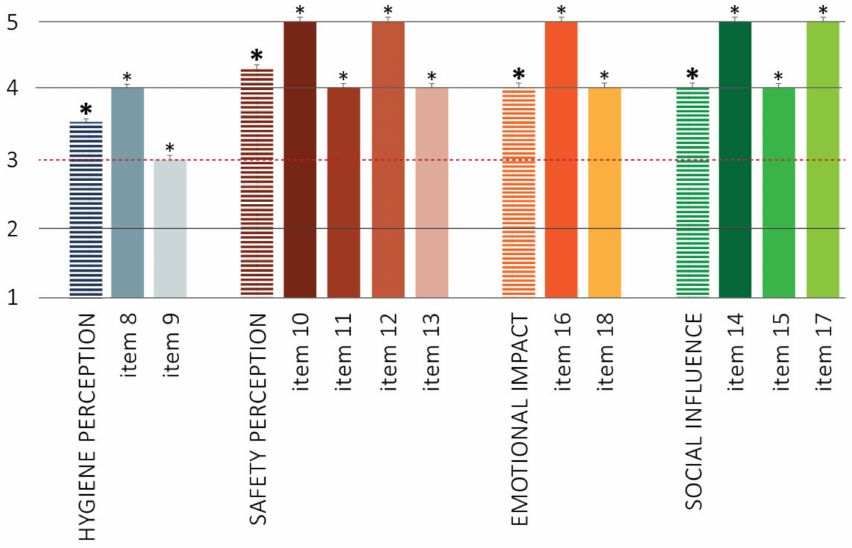
Figure 4. Hand-sanitizing systems: median values of the scores given by the users, differentiated per dimension and item. * dimension, p < 0.05; * item, p < 0.05. Own processing.